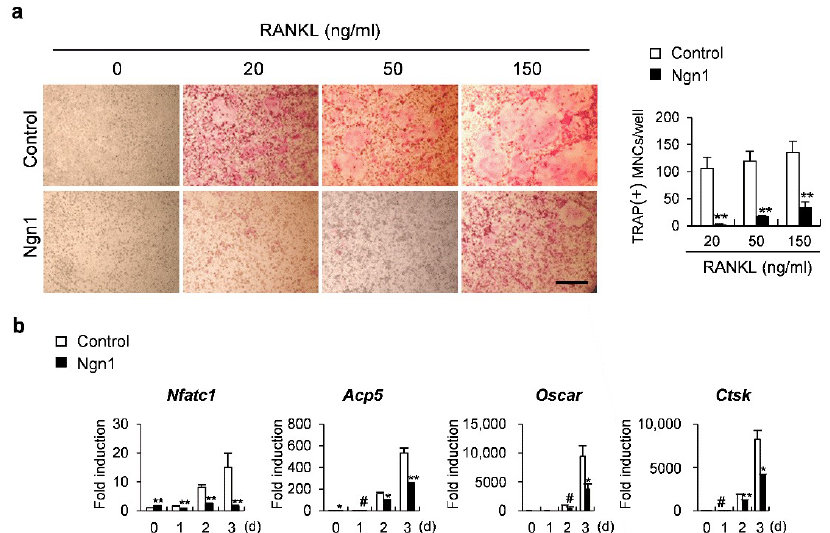
Figure 1. The overexpression of Neurogenin 1 (Ngn1) inhibited the receptor activator of nuclear factor kappa-B ligand (RANKL)-induced osteoclast differentiation. ( a , b ) Bone marrow-derived mac- rophages (BMMs) overexpressing Ngn1 were generated via retroviral infection and cultured with a macrophage colony stimulating factor (M-CSF) and RANKL for 3 days. ( a ) Tartrate-resistant acid phosphatase (TRAP)-stained cells (left panel) and the number of TRAP-positive multinucleated cells (right panel), scale bar: 200 µm. ( b ) Relative expression of the indicated genes quantified using quan- titative reverse-transcription PCR (qRT-PCR). # p < 0.05, * p < 0.01, ** p < 0.001 vs. control.